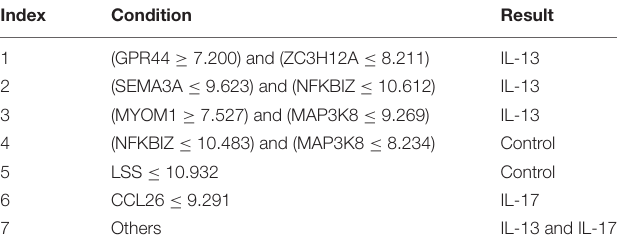
TABLE 2 | Rules by RIPPER on expression